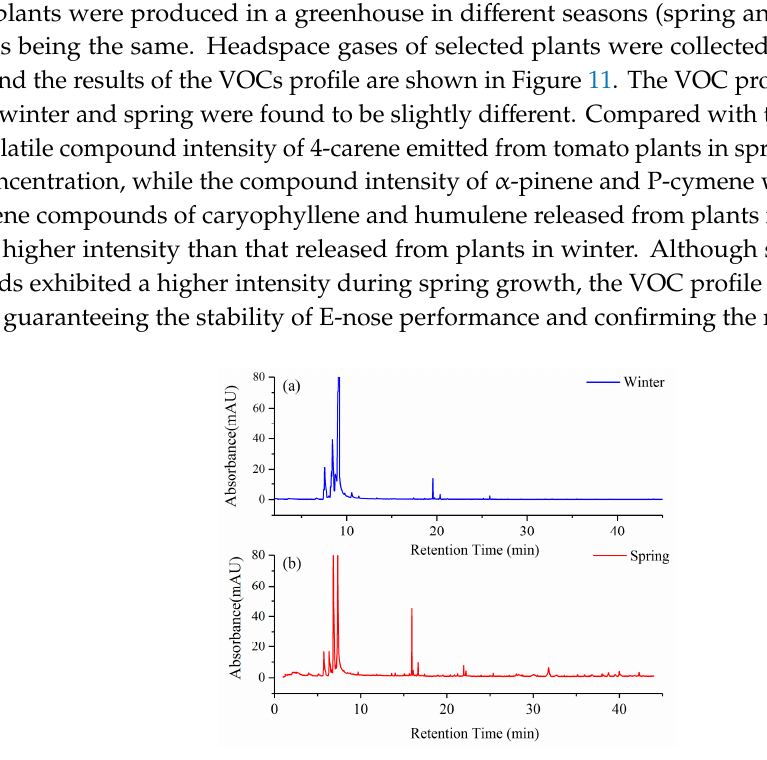
Figure 11. The GC-MS spectrum of tomato plants growing in spring and winter.